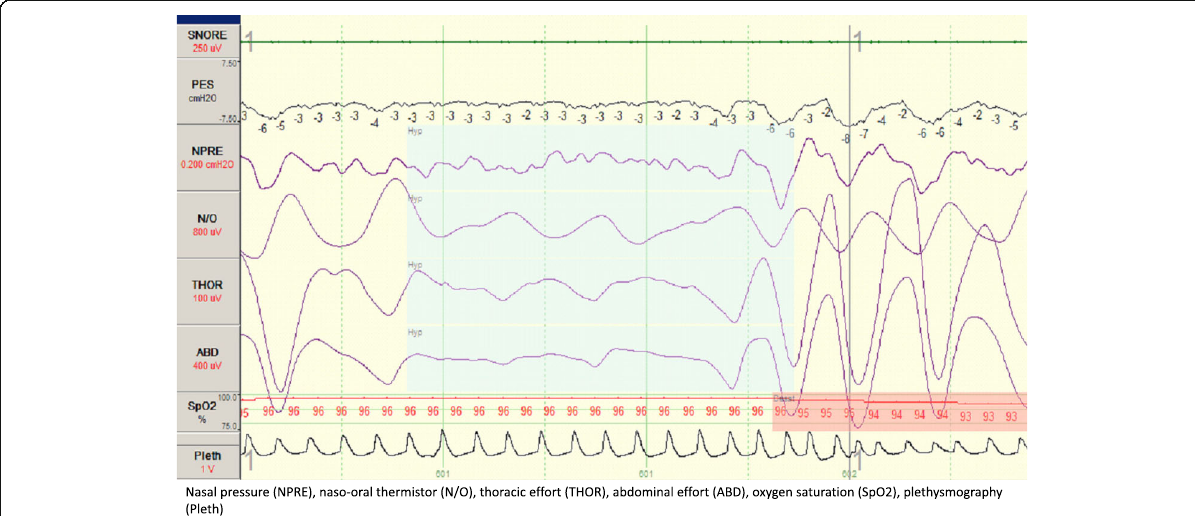
Fig. 5 A central hypopnea lacks the obstructive features seen in Fig. 4. The lack of elevated Pes values also confirms the central etiology of the